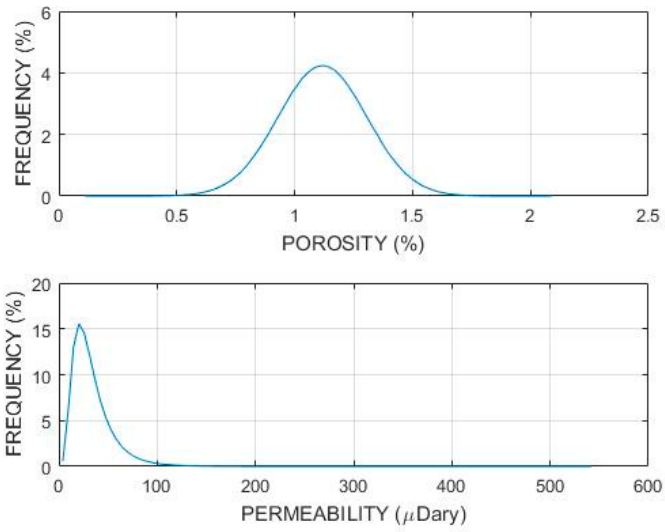
Figure 6. Frequency distributions typical of ambient porosity and permeability fluctuations embedded in Figure 5 numerical crustal volume characterized by spatially correlated porosity and permeability empirics (I)–(III).